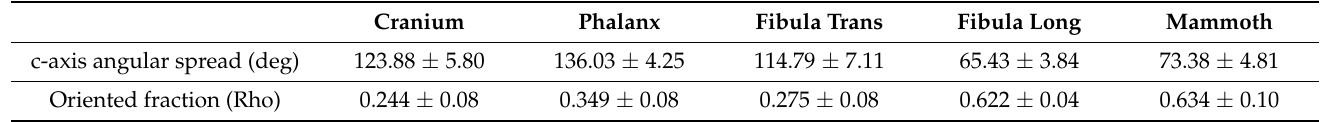
Table 2. Crystals orientation parameters determined by X-ray diffraction in different bone samples obtained by 2D-XRD patterns analyses.